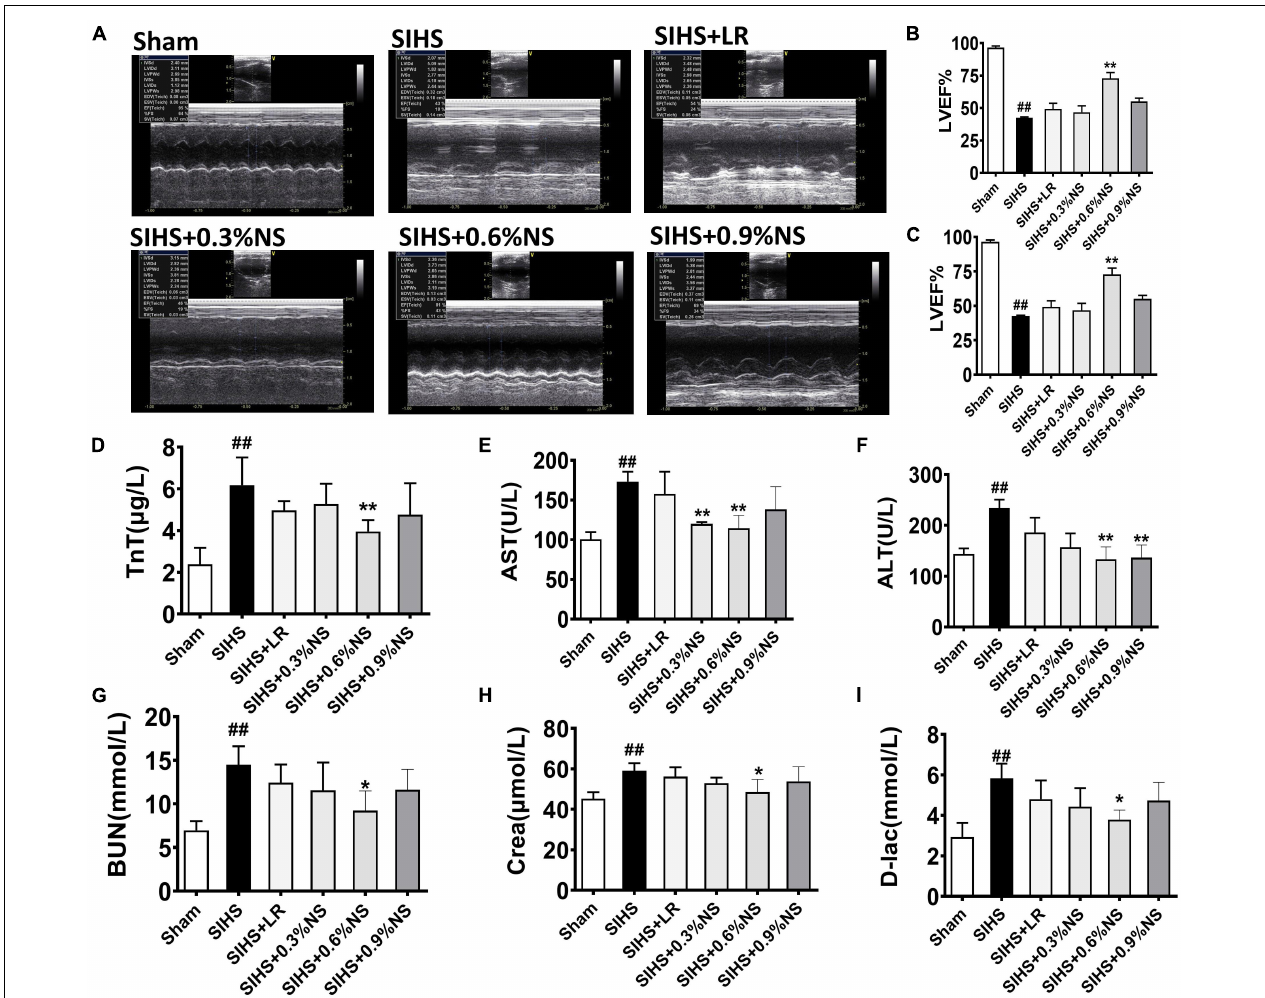
FIGURE 6 | Effects of different osmotic fluids on vital organ function with seawater immersion in hemorrhagic shock rats ( n = 8/group). (A) Echocardiograms. (B–C) Summary of cardiac ejection fraction (EF) (B) and fractional shortening (FS) (C) measured using echocardiography. (D) Troponin T (TnT). (E) Aspartate transaminase (AST). (F) Alanine aminotransferase (ALT). (G) Urea nitrogen (BUN). (H) Creatinine (Crea). (I) D -Lactate. Sham, Sham-operated group; SIHS, seawater immersion combined with hemorrhagic shock; LR, lactated Ringer’s solution; NS, normal saline. * p < 0.05 and ** p < 0.01, compared with the control group. ## p < 0.01, compared with the Sham